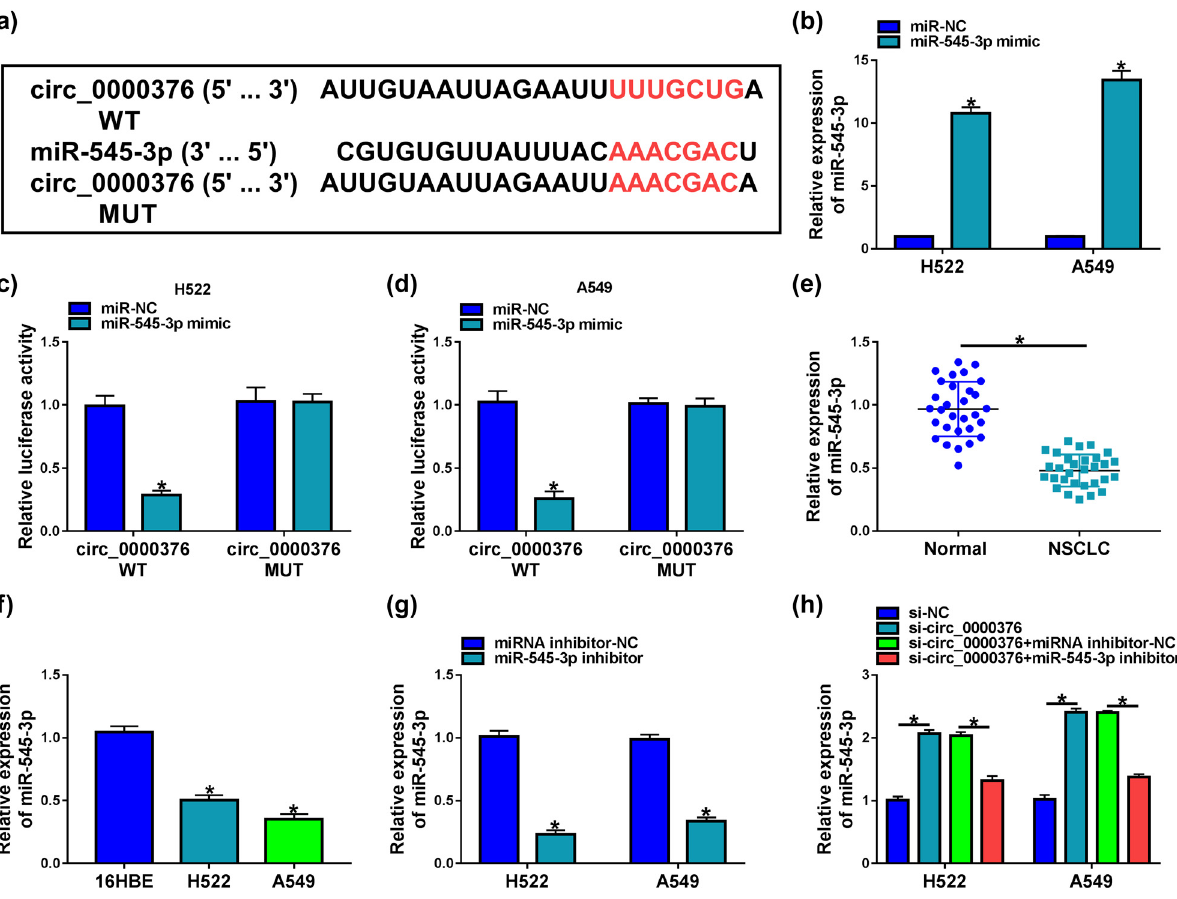
Figure 3: circ_0000376 interacted with miR - 545 - 3p in H522 and A549 cells. ( a ) Binding sites between circ_0000376 and miR - 545 - 3p were predicted by the circular RNA interactome online database. ( b and g ) E ffi ciency of miR - 545 - 3p mimic and inhibitor in increasing or